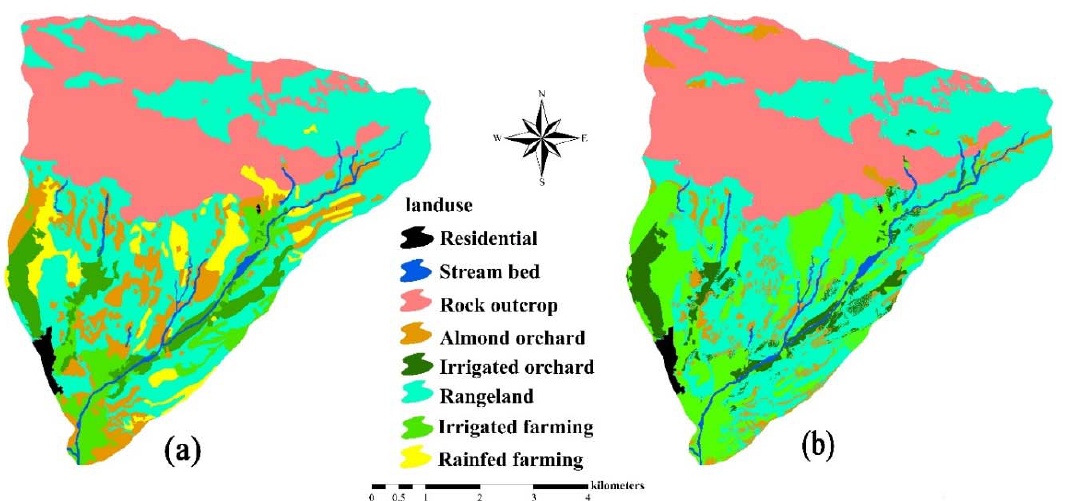
Fig. 8: Land use map (a) before and (b) after optimization